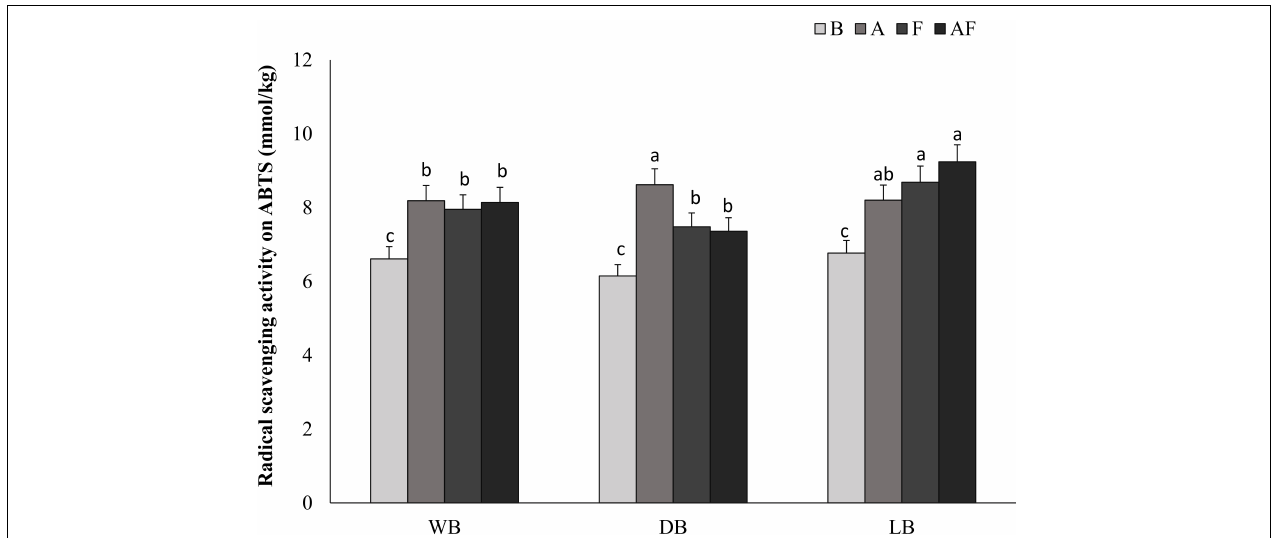
FIGURE 4 | Antioxidant activity expressed as ABTS (millimoles per kilogram, Trolox) radical scavenging activity determined on wet (WB, panel A ), dried at low temperature (DB, panel B ), and lyophilized (LB, panel C ). All biomasses were also treated with Alcalase R (cid:13) (A, 1% vol/wt), fermented with L. plantarum T0A10 (F, final cell density of circa 7 log10 cfu/g), or fermented and treated with Alcalase R (cid:13) (AF). Enzymatic and microbial treatments were carried out at 30 ◦ C for 24 h. a–c Values with different superscript letters differ significantly ( P <